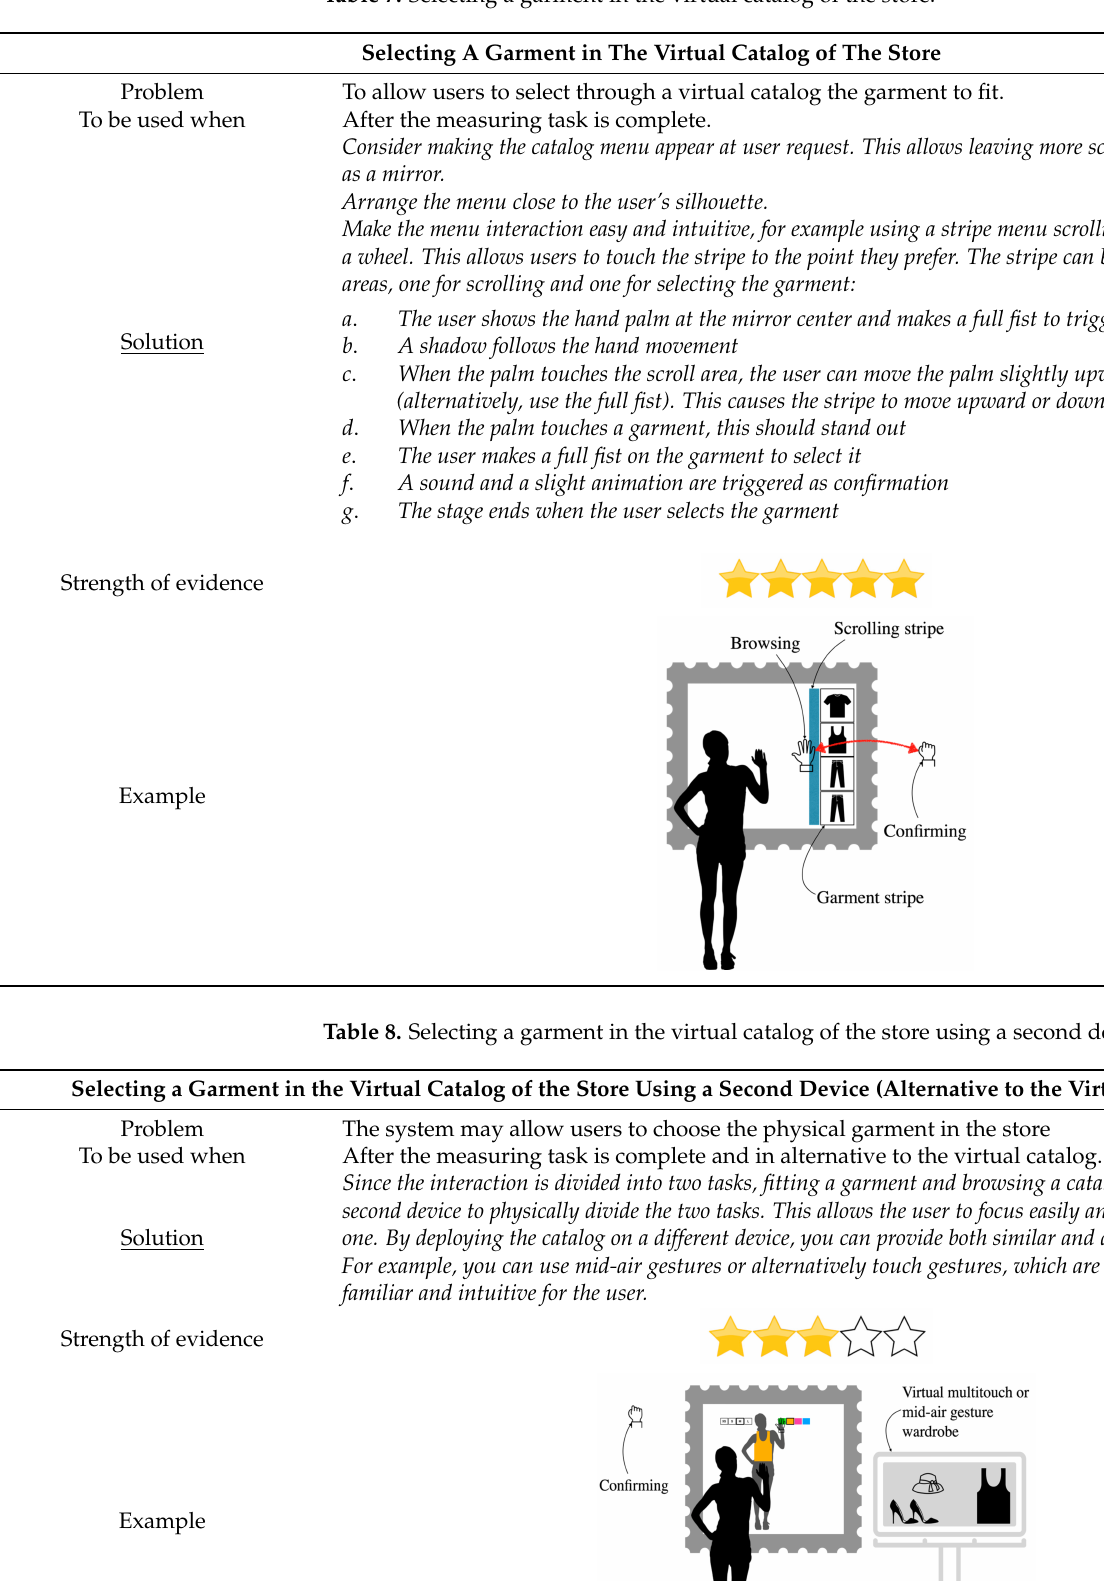
Table 7. Selecting a garment in the virtual catalog of the store.